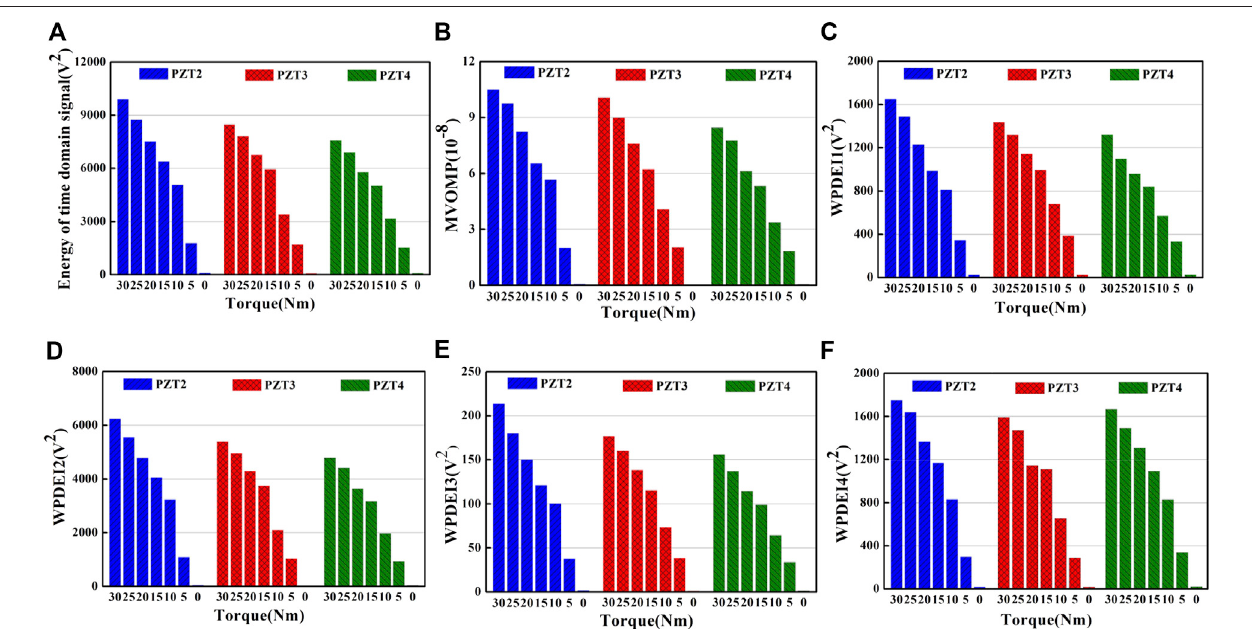
FIGURE 11 | Looseness indicators of different channels under different torque levels. (A) Indicator of signal energy. (B) Maximum value of the mean periodogram. (C) First component of the wavelet packet energy. (D) Second component of the wavelet packet energy. (E) Third component of the wavelet packet energy. (F) Fourth component of the wavelet packet